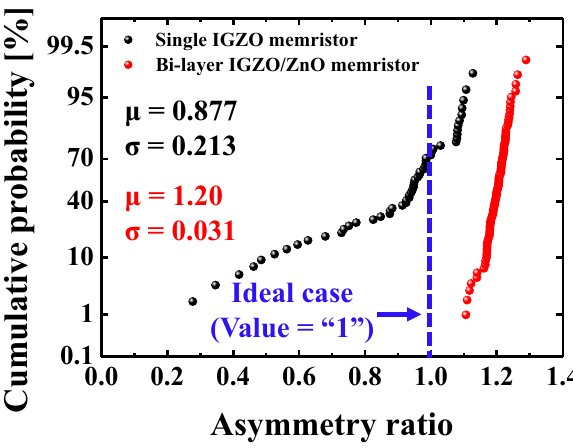
Figure 9. Asymmetry ratio distribution of a single IGZO and bi-layer IGZO/ZnO memristors. The standard deviation of bi-layer IGZO/ZnO memristors shows much more improvement compared to that of a single IGZO memristor, meaning close to ideal synapse device.